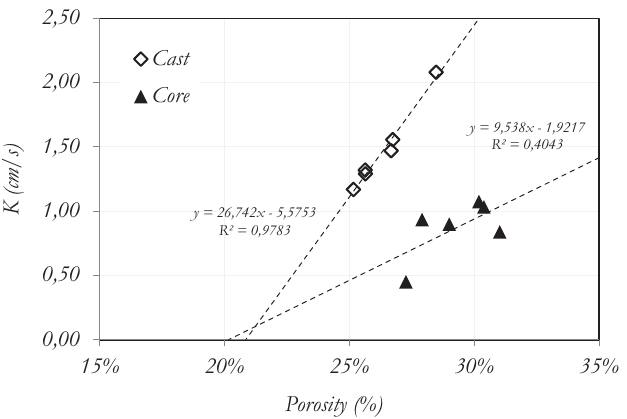
Figure 10 Infiltration rate vs. porosity of cast and cored specimens